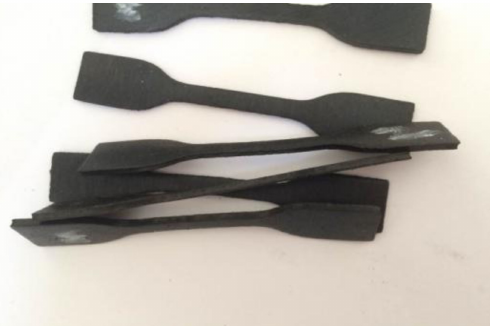
Figure 2. Dumbbell-shaped specimens of the high-damping rubber material for tension tests.